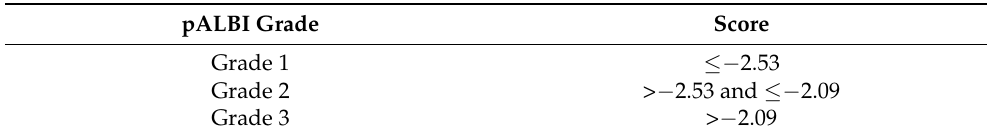
Table 5. Platelet–ALBI (pALBI)